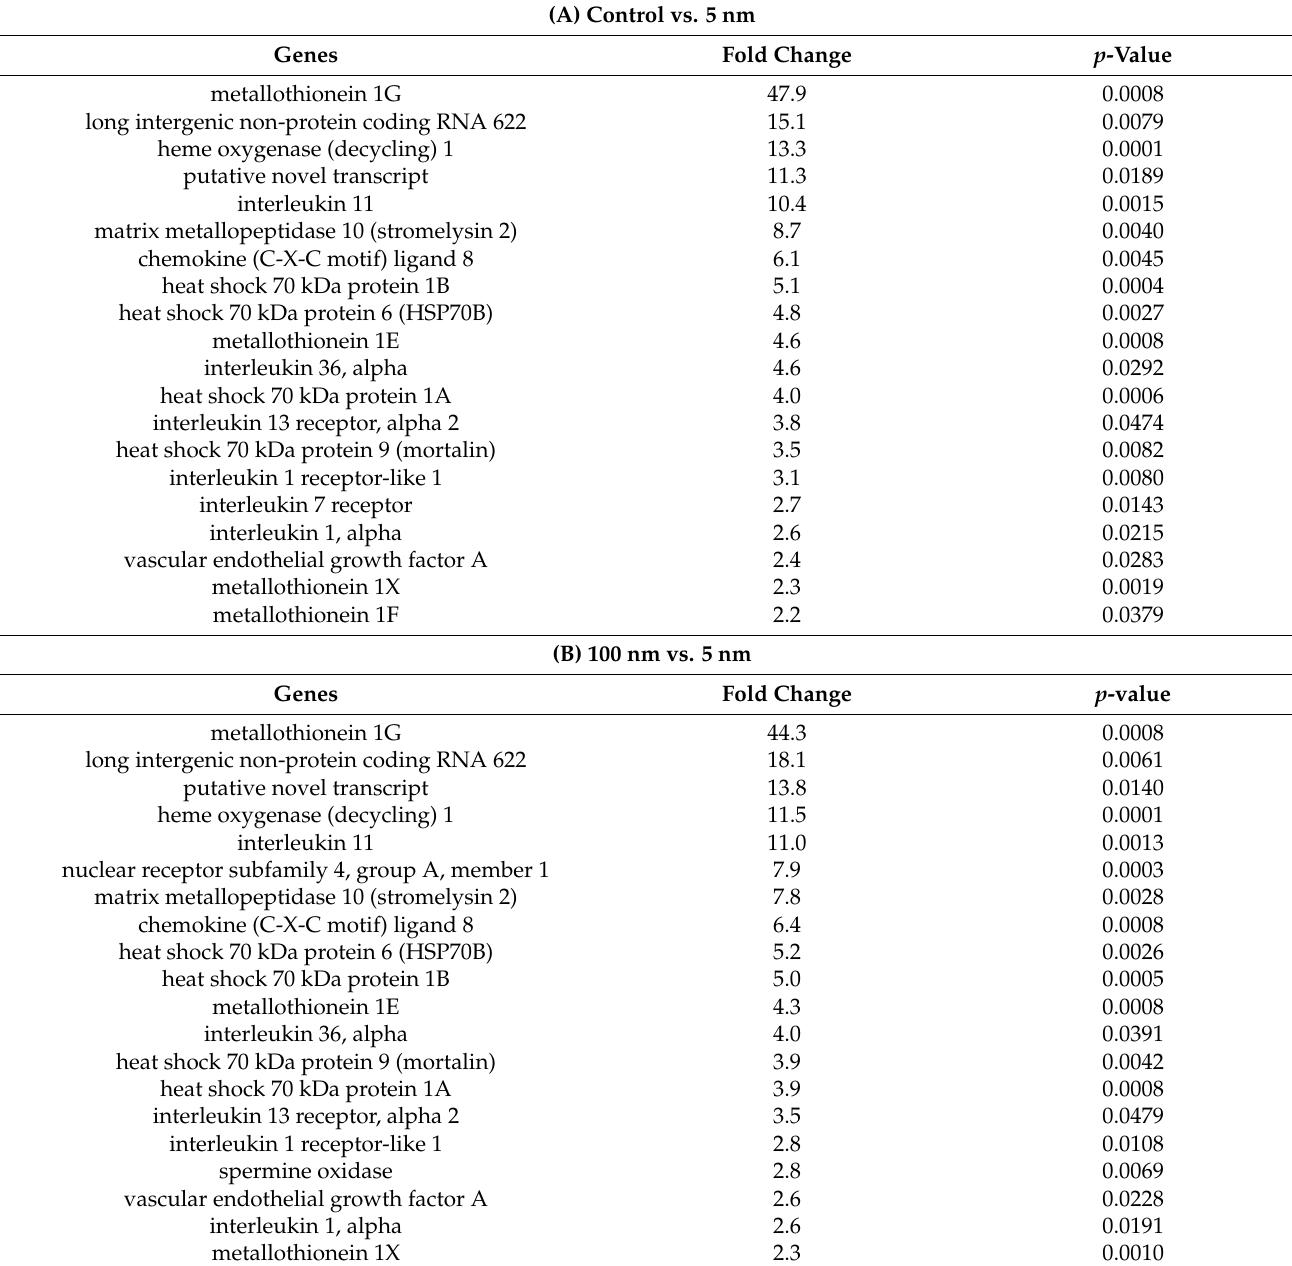
Table 2. List of increased genes after silver NP exposure in EA.hy926 cells.